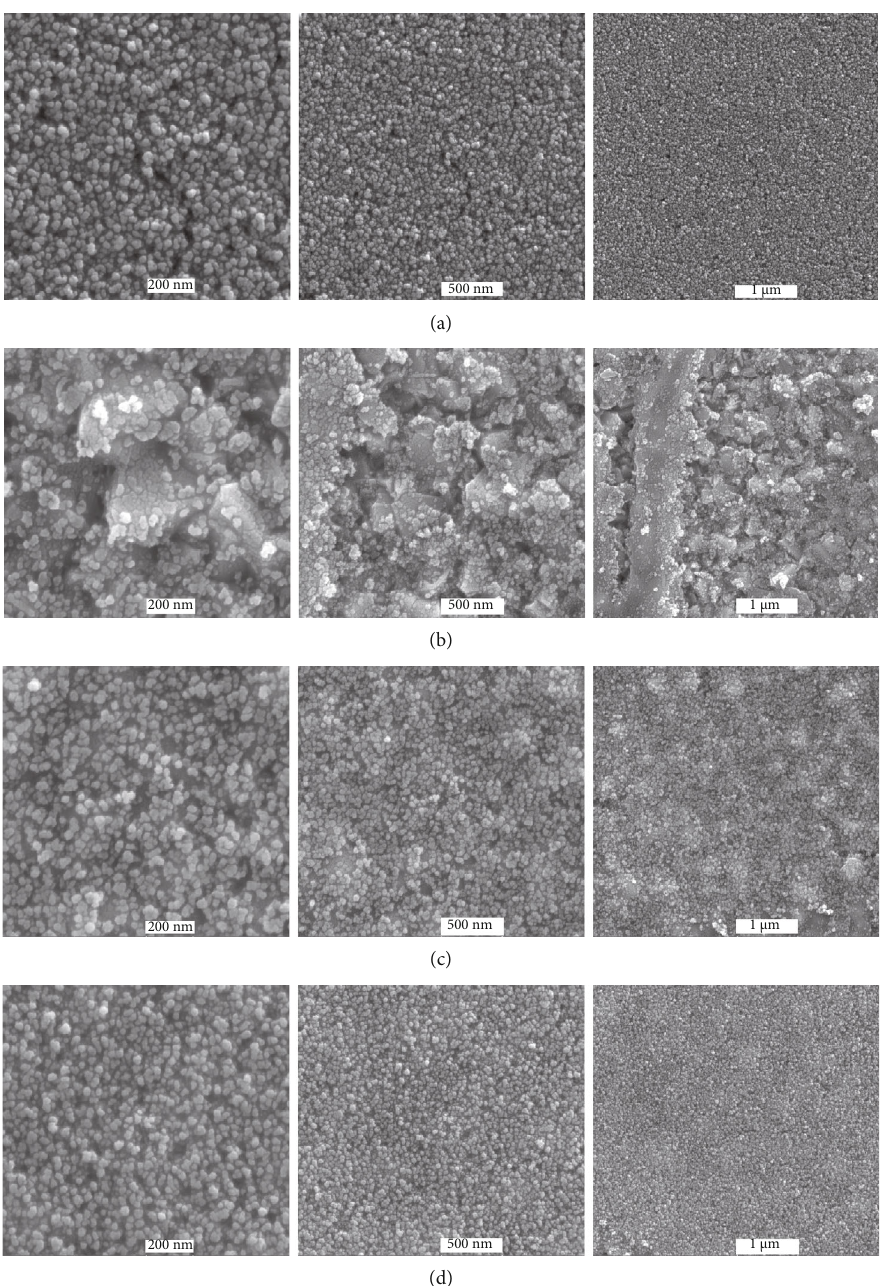
Figure 5: The FESEM image of (a) HT, (b) LT1, (c) LT2, and (d) LT3, in three